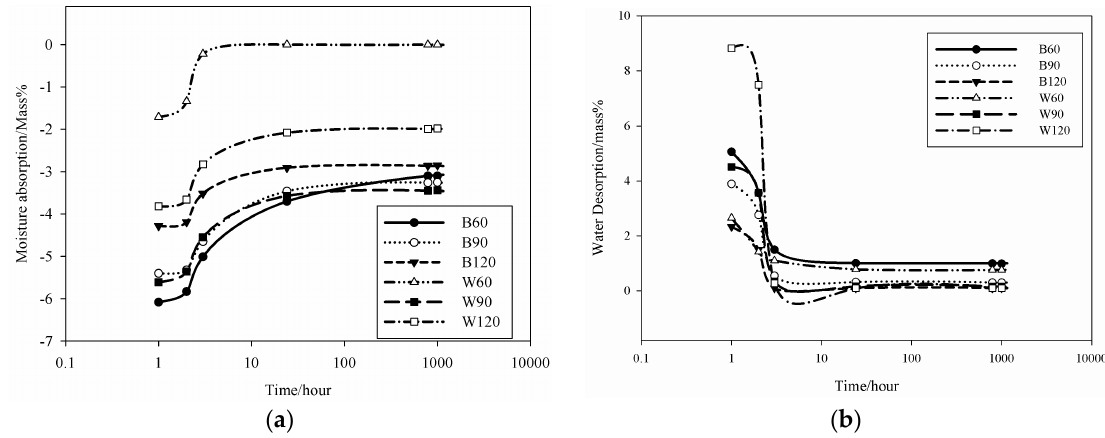
Figure 6. Moisture absorption-desorption performance of the slag-based AAS mortars: ( a ) moisture absorption performance at ambient temperature after 24 h in oven at 100 °C; and ( b ) moisture desorption performance at ambient temperature after complete saturation in water.